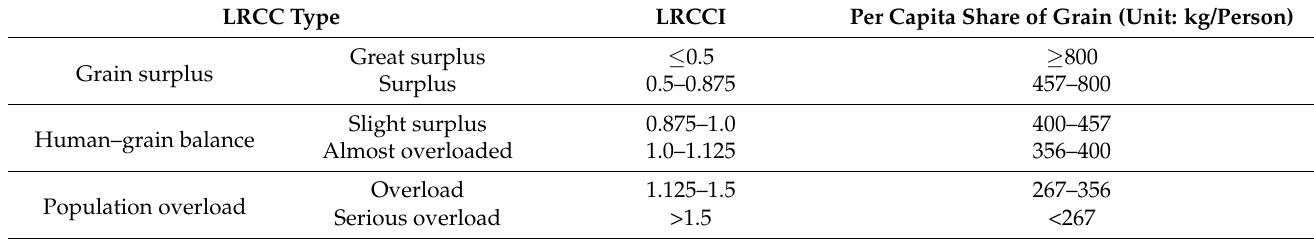
Table 1. Type of LRCC based on